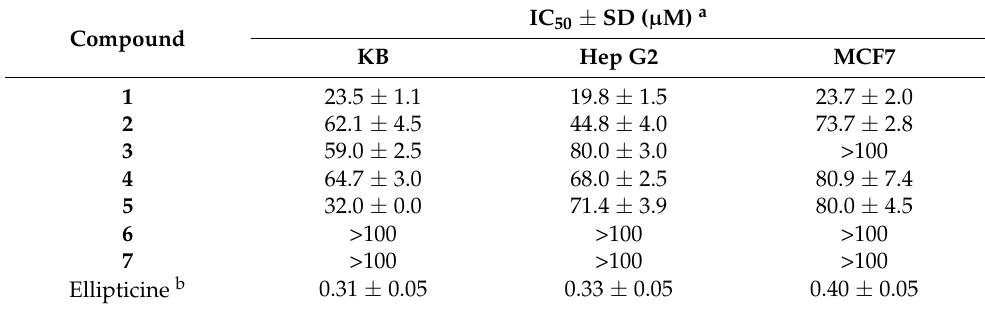
Table 3. Cytotoxicity of 1 – 7 against three human cancer cell